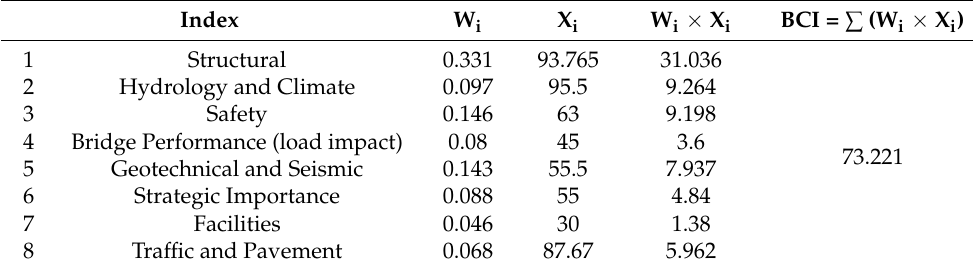
Figure 11. An example of block in the facilities of drainage system (bridge No. 2). Table 19. BCI calculation of the bridge No.